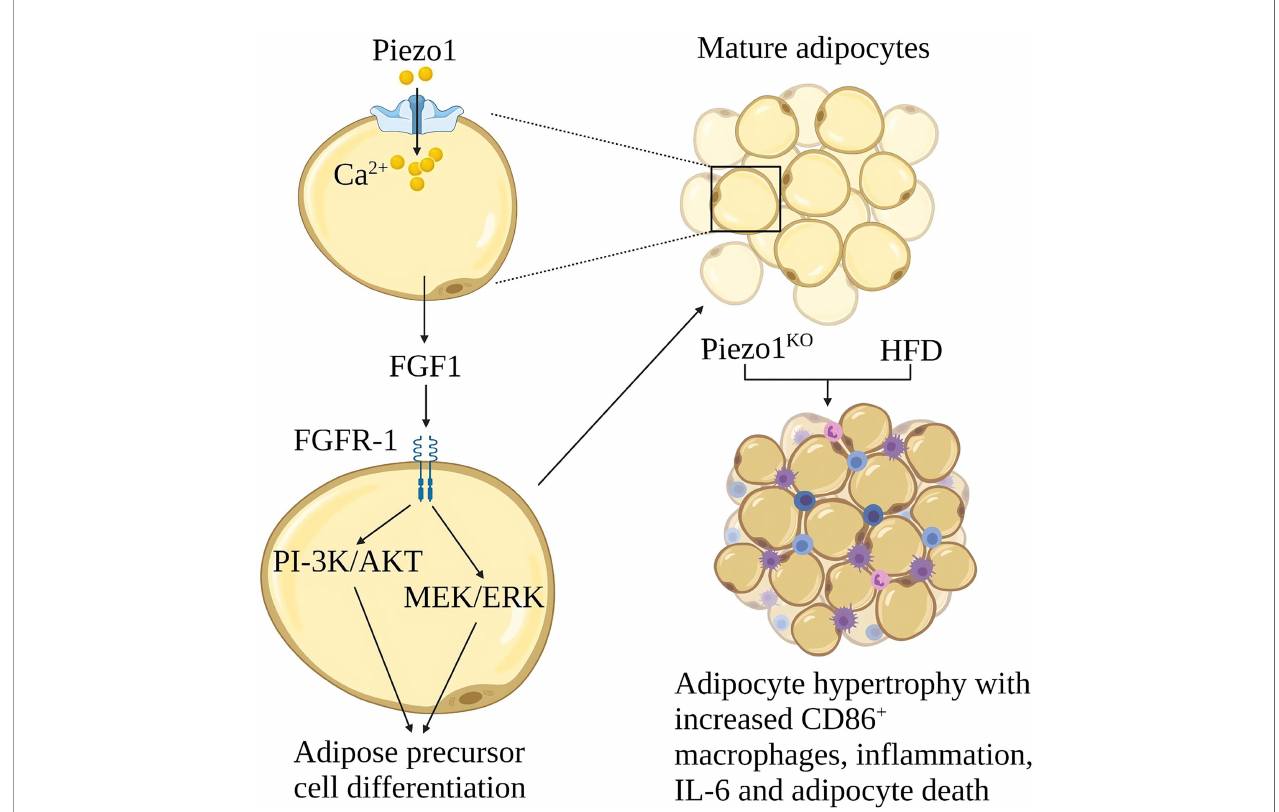
FIGURE 10 | Schematic diagram of the role of Piezo1 in obesity and insulin resistance. Opening Piezo1 on mature adipocytes promotes FGF1 secretion, which induces adipose precursor cell differentiation. Mice lacking Piezo1 in adipocytes developed adipose progenitor cell differentiation disorder and increased hypertrophy after a high-fat diet, with increased CD86 + macrophages, in fl ammation, IL-6, and adipocyte